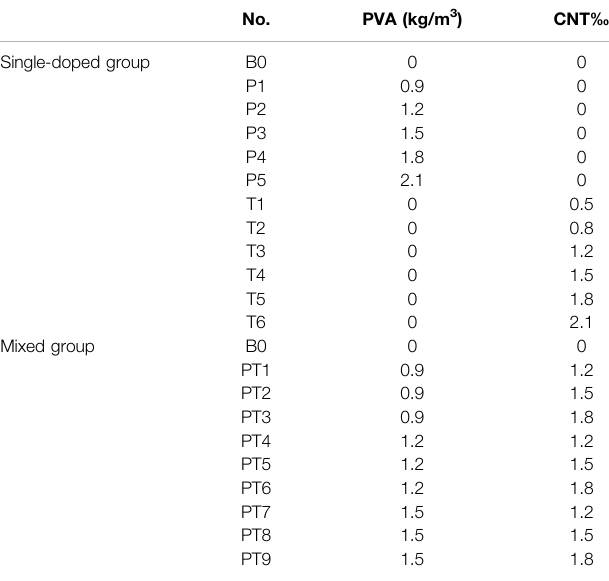
TABLE 3 | Single-doped PVA fi bre, single-doped CNT, and mixed-doped strengthened geopolymer test group arrangement. No. PVA (kg/m 3